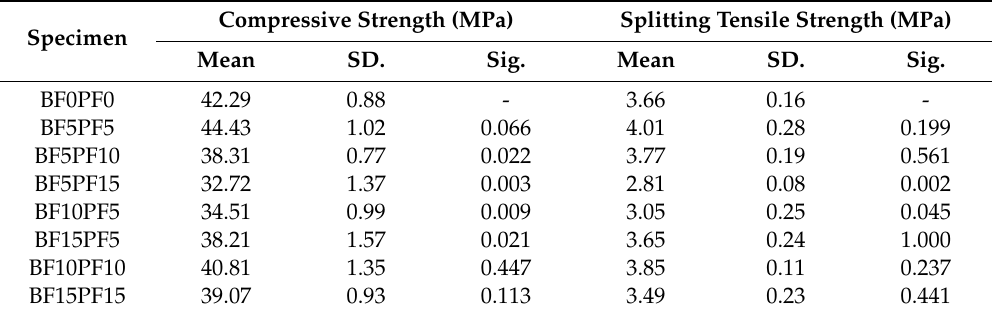
Table 4. Compressive strength and splitting tension strength results of di ff erent mixtures. Compressive Strength Specimen